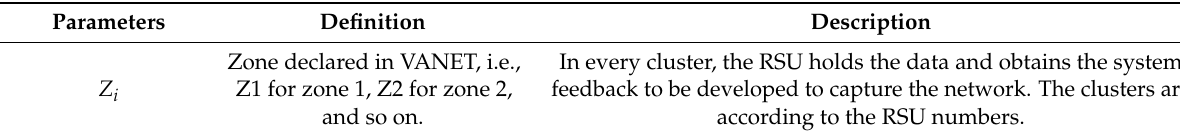
Table 2. Parameters with the descriptions used for the proposed methodology.